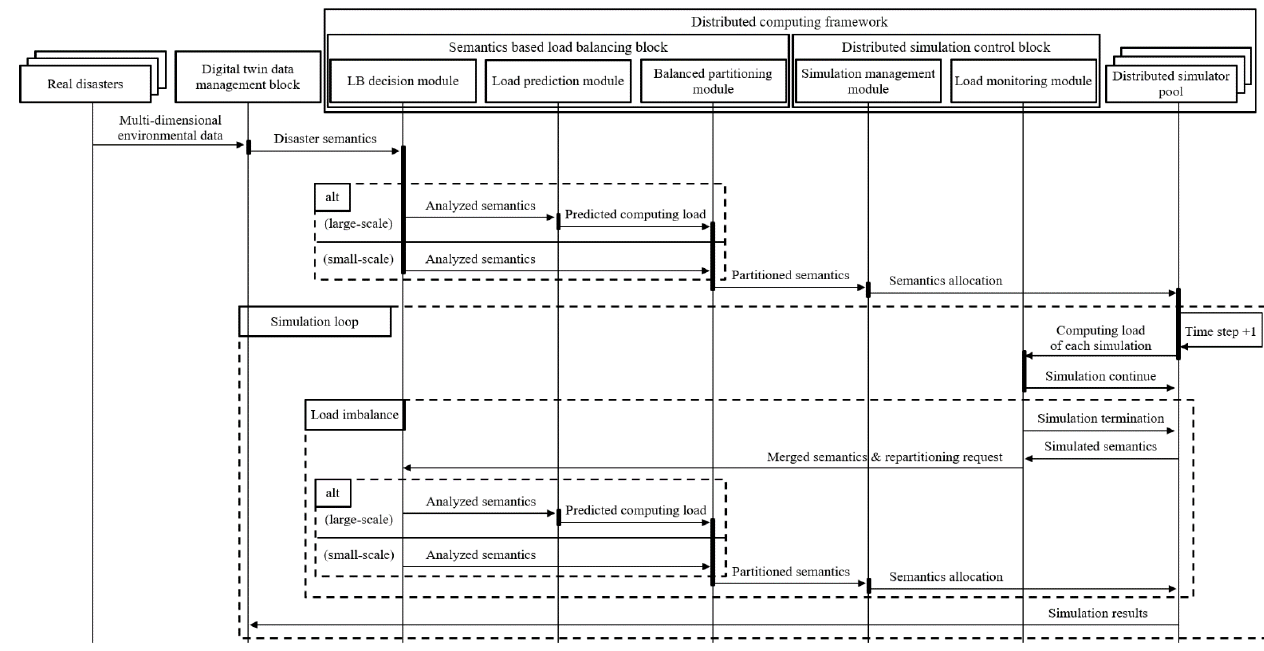
Figure 9. The sequence diagram of the digital twin service for large-scale disasters.